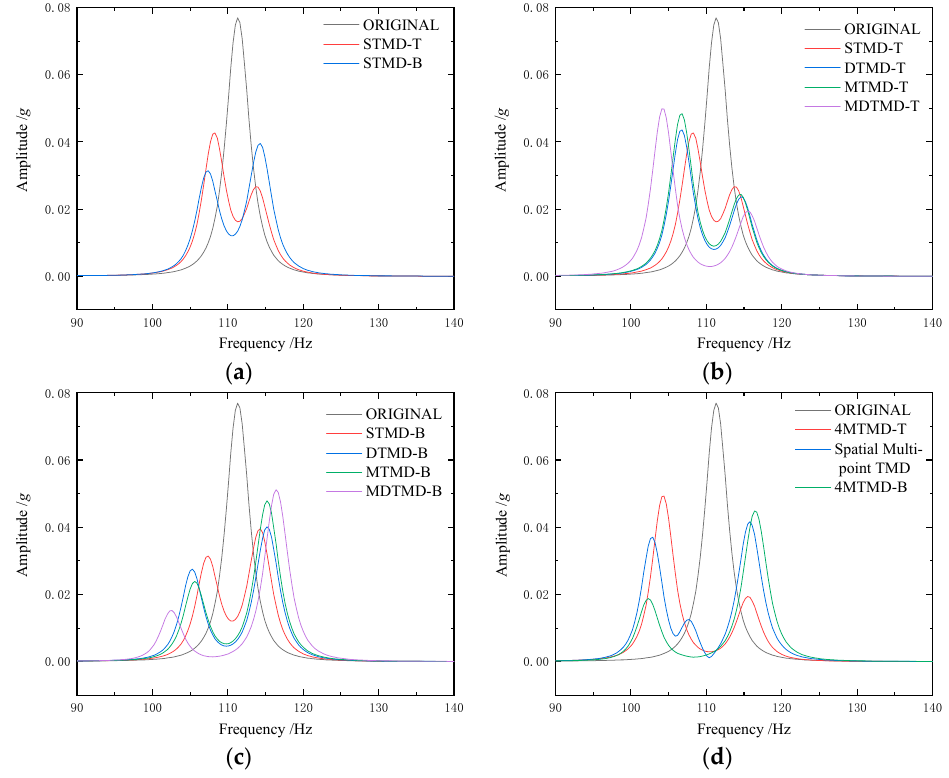
Figure 15. Frequency domain response curves of top layer of original structure and additional TMD damping structure: ( a ) STMD damping structure with different locations; ( b ) four cases of TMD placement on top of the structure; ( c ) four cases of TMD placement on the bottom of the structure; and ( d ) the quadruple TMD damping structure.